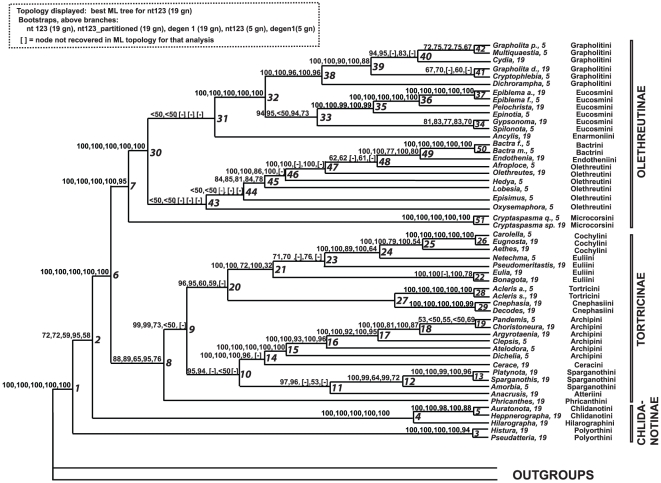
Maximum likelihood estimate of phylogenetic relationships in Tortricidae.Tree was obtained from 1000 GARLI searches under a GTR+gamma+I model for all nucleotides (unpartitioned). Bootstrap support values (742–901 pseudoreplicates) above branches for: nt123 (19 genes), nt123_partitioned (19 genes), degen1 (19 genes), nt123 (5 genes), degen1 (5 genes). “[-]” = node not present on best ML tree for that analysis. Nodes within Tortricidae are numbered (to the right of node) for purposes of discussion.